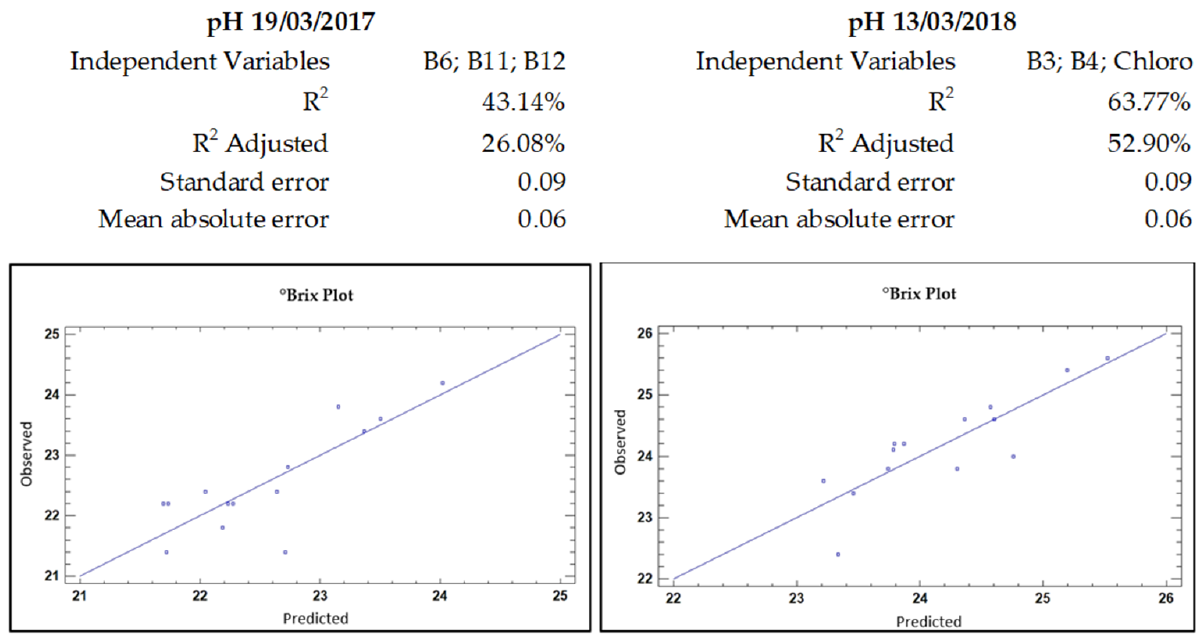
Figure 10. pH multiple regression statistics in both seasons.